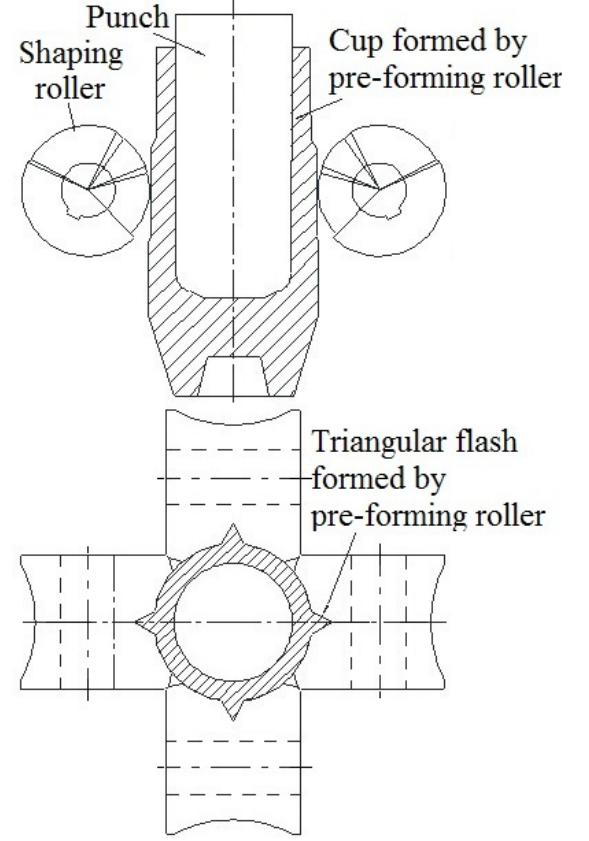
Figure 4. Shaping during roll